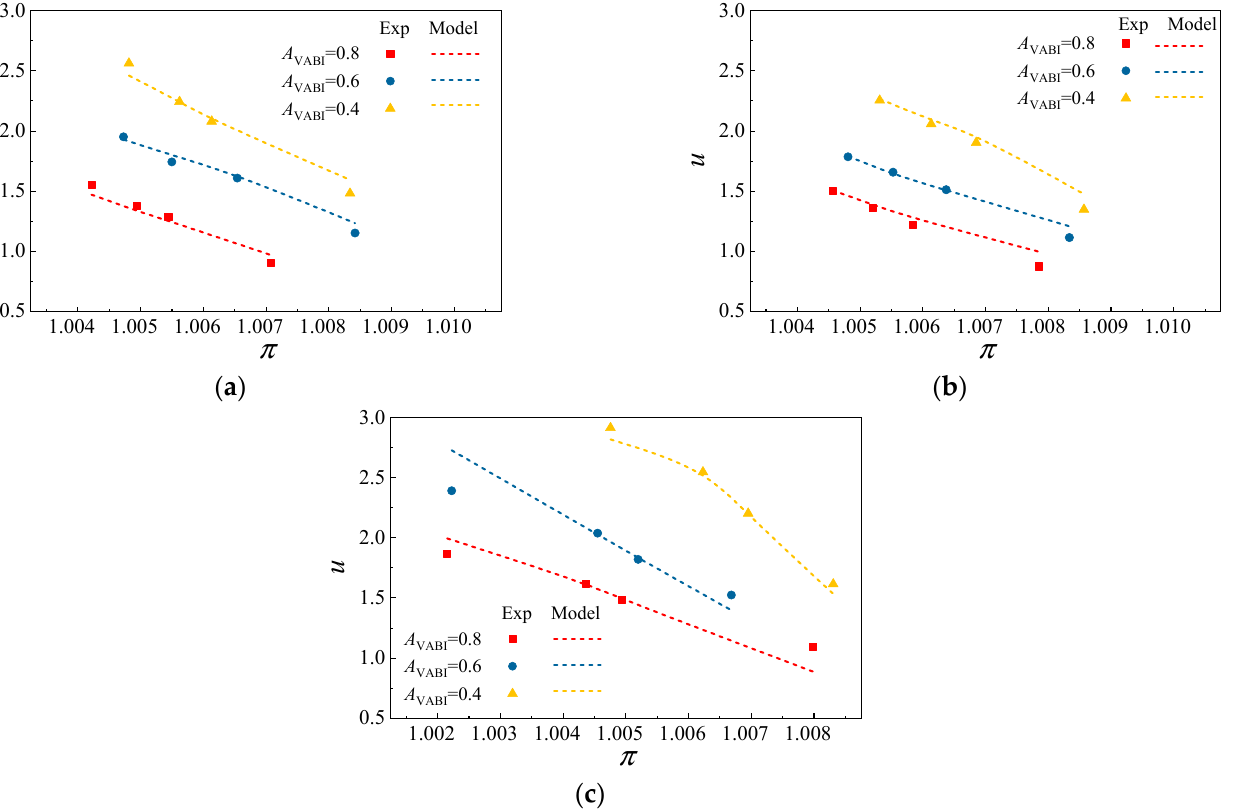
Figure 19. The variation in the VABI injection ratio with bypass total pressure ratio: ( a ) α VABI = 35°, ( b ) α VABI = 25°, and ( c ) α VABI = 15°.